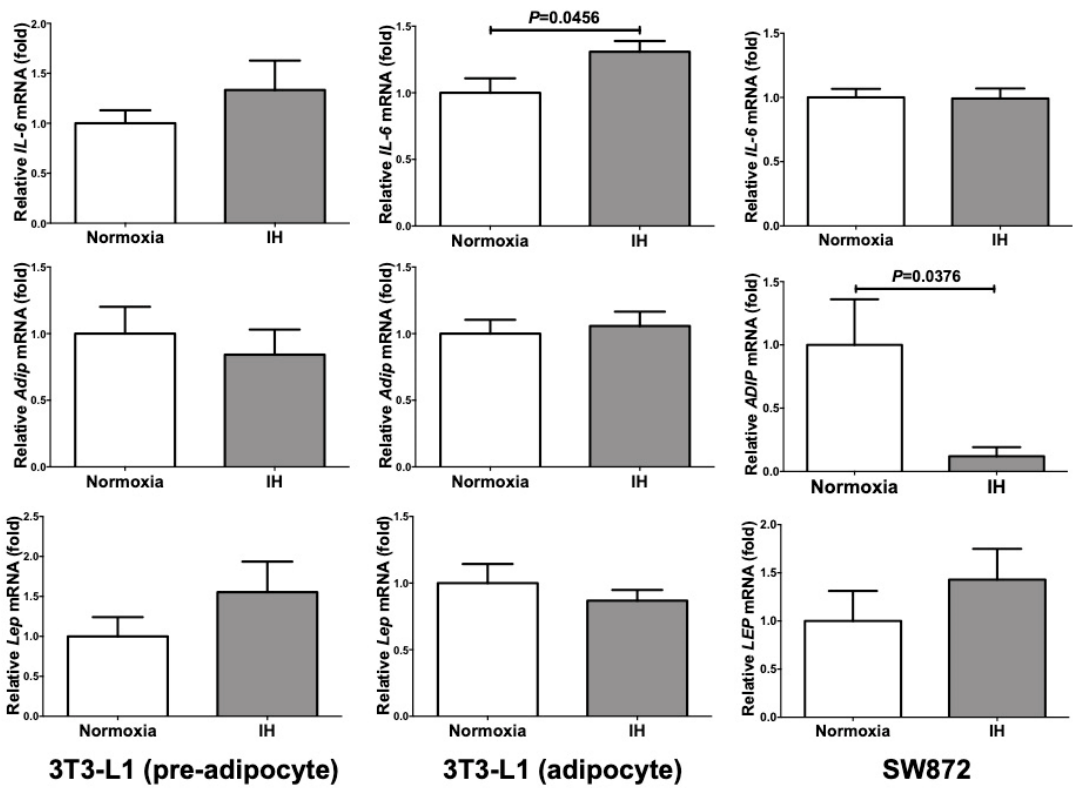
Figure 2. The mRNA levels of Il-6 , Adip , and Lep in 3T3-L1 cells (pre-adipocyte and adipocyte) and SW872 cells treated by normoxia or IH for 24 h. The levels of the adipokine mRNAs were measured by real-time RT-PCR using Rig / RpS15 (in mouse) and β -actin (in human) as an endogenous control. Data is expressed as mean ± SE for each group ( n = 4). The statistical analyses were performed using Student’s t -test.